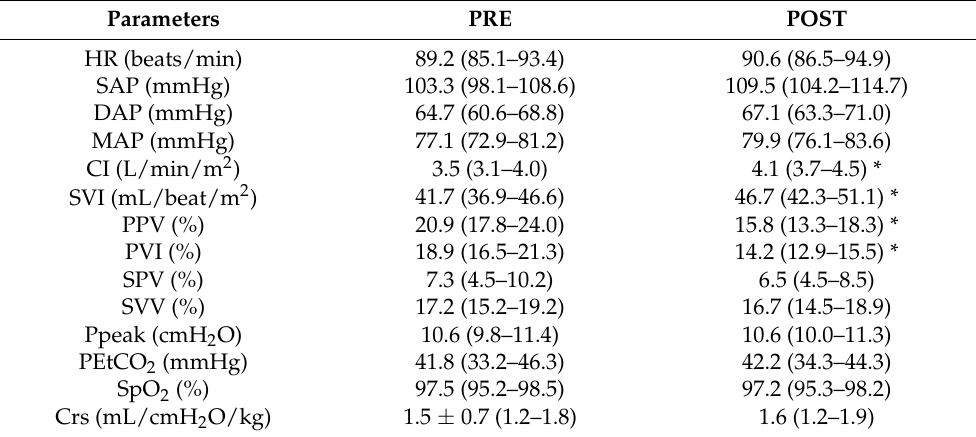
In Table 3, the cut-off values, sensitivities, specificities, AUCs, grey-zone limits, and number of grey-zone cases are reported for each dynamic variable and the MAP. Table 1. Mean and 95% confidential intervals of cardiovascular and respiratory parameters collected from 80 dogs under general anaesthesia before (PRE) and 2 min after (POST) a fluid challenge administration of 5 mL/kg of Ringer’s lactate within 5 min.